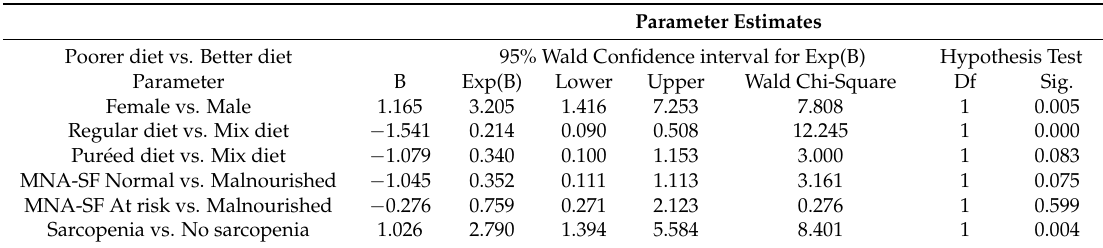
Table 4. Parameter estimates from the multivariate logistic regression model fitted to the dietary patterns. Parameter Estimates Poorer diet vs. Better diet 95% Wald Confidence interval for